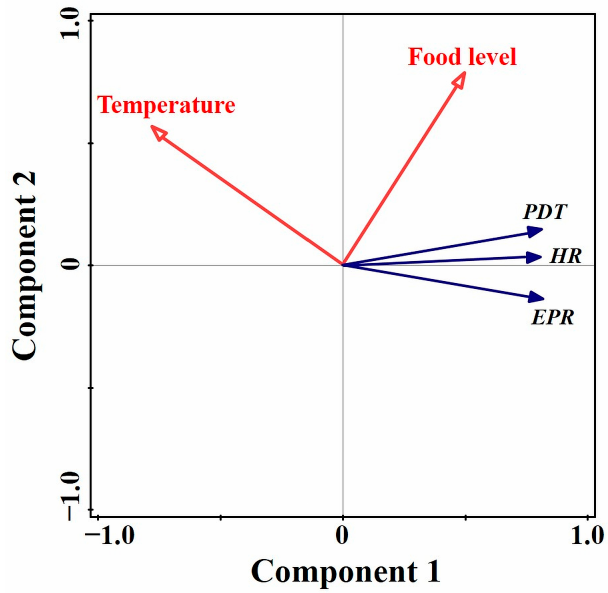
Figure 8. PCA scatter diagrams of Acartia bifilosa population recruitment parameters (EPR, HR, PDT) and the environmental parameters (temperature and food level) in the Jiaozhou Bay. (EPR: egg production rate; HR: hatching rate; PDT: post-embryonic development